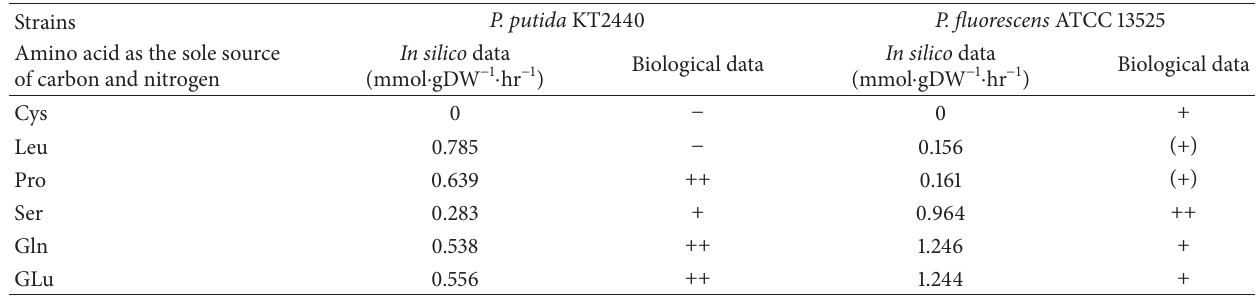
Table 4: Qualitative growth profiles of P. putida and P. fluorescens on three amino acids. Relative growth rates were estimated qualitatively. Strains P. putida KT2440 Amino acid as the sole source of carbon and